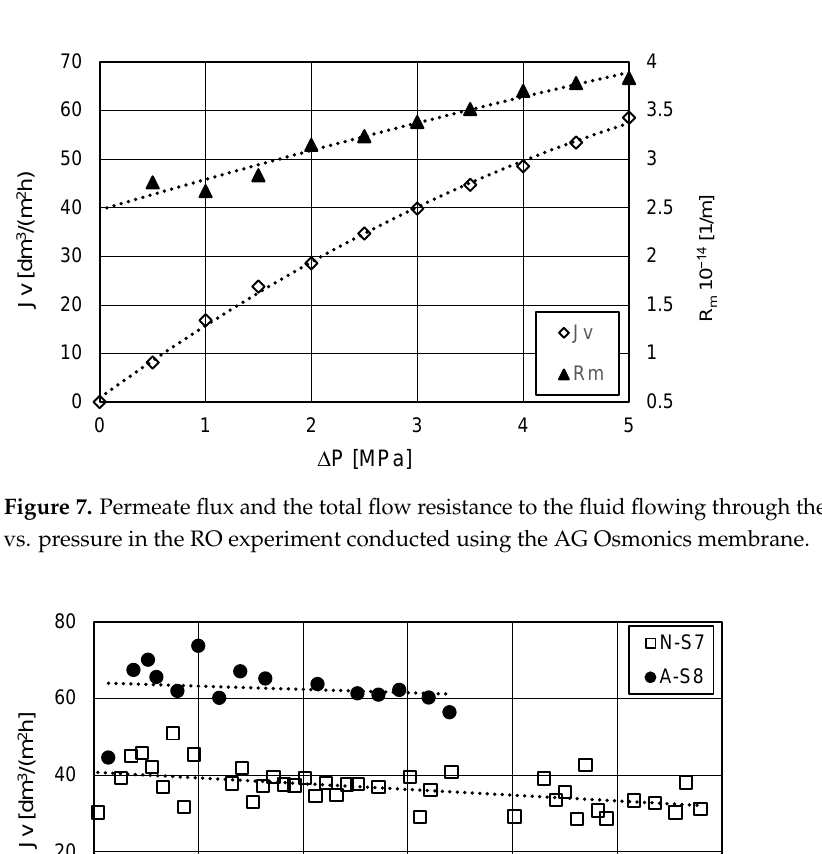
The membrane resistance was stable with time. The resistance was about 4 × 10 14 m −1 for the wastewater with a nonionic agent (N-S7) and about 2 × 10 14 m −1 for the wastewater with an anionic agent (A-S8). A significantly higher flux and lower resistance were ob- served for the feed that originally contained the anionic agent.